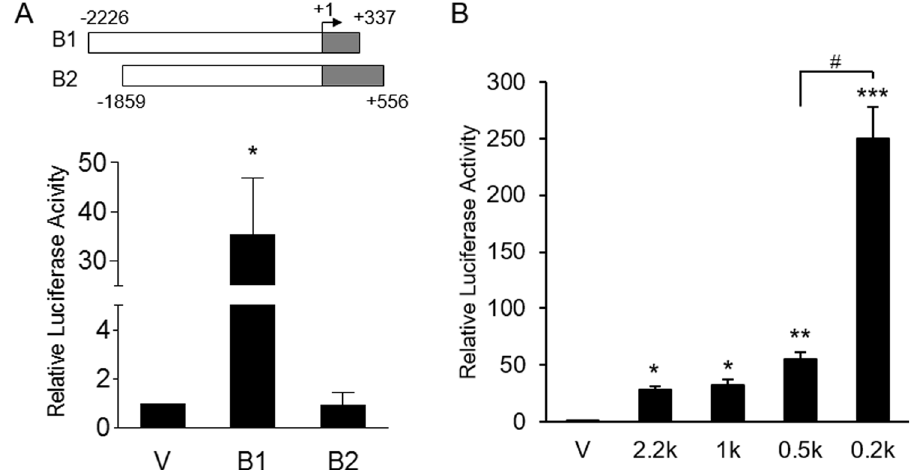
Figure 1. Transcriptional activity of the human HSD3B1 promoter. ( A ) The human HSD3B1 (B1: − 2226/ + 337) and HSD3B2 (B2: − 1859/ + 556) promoter regions (shown on the top) were fused to luciferase reporter to generate promoter-luciferase constructs. “ + 1” is the transcription start site indicated by the arrow. The HSD3B1 , HSD3B2 or empty (v) promoter-luciferase construct was transiently transfected into JEG-3 cells. ( B ) A series of 5 ′ -deleted HSD3B1 promoter-luciferase constructs were transiently transfected into JEG-3 cells. Cells were harvested after 24 h of transfection and assayed for luciferase activity. Results are presented as the activity relative to the empty vector. Data are means ± SD of five ( A ) or three ( B ) independent experiments. * P < 0.05, ** P < 0.01, *** P < 0.001 compared with vector control. # P <